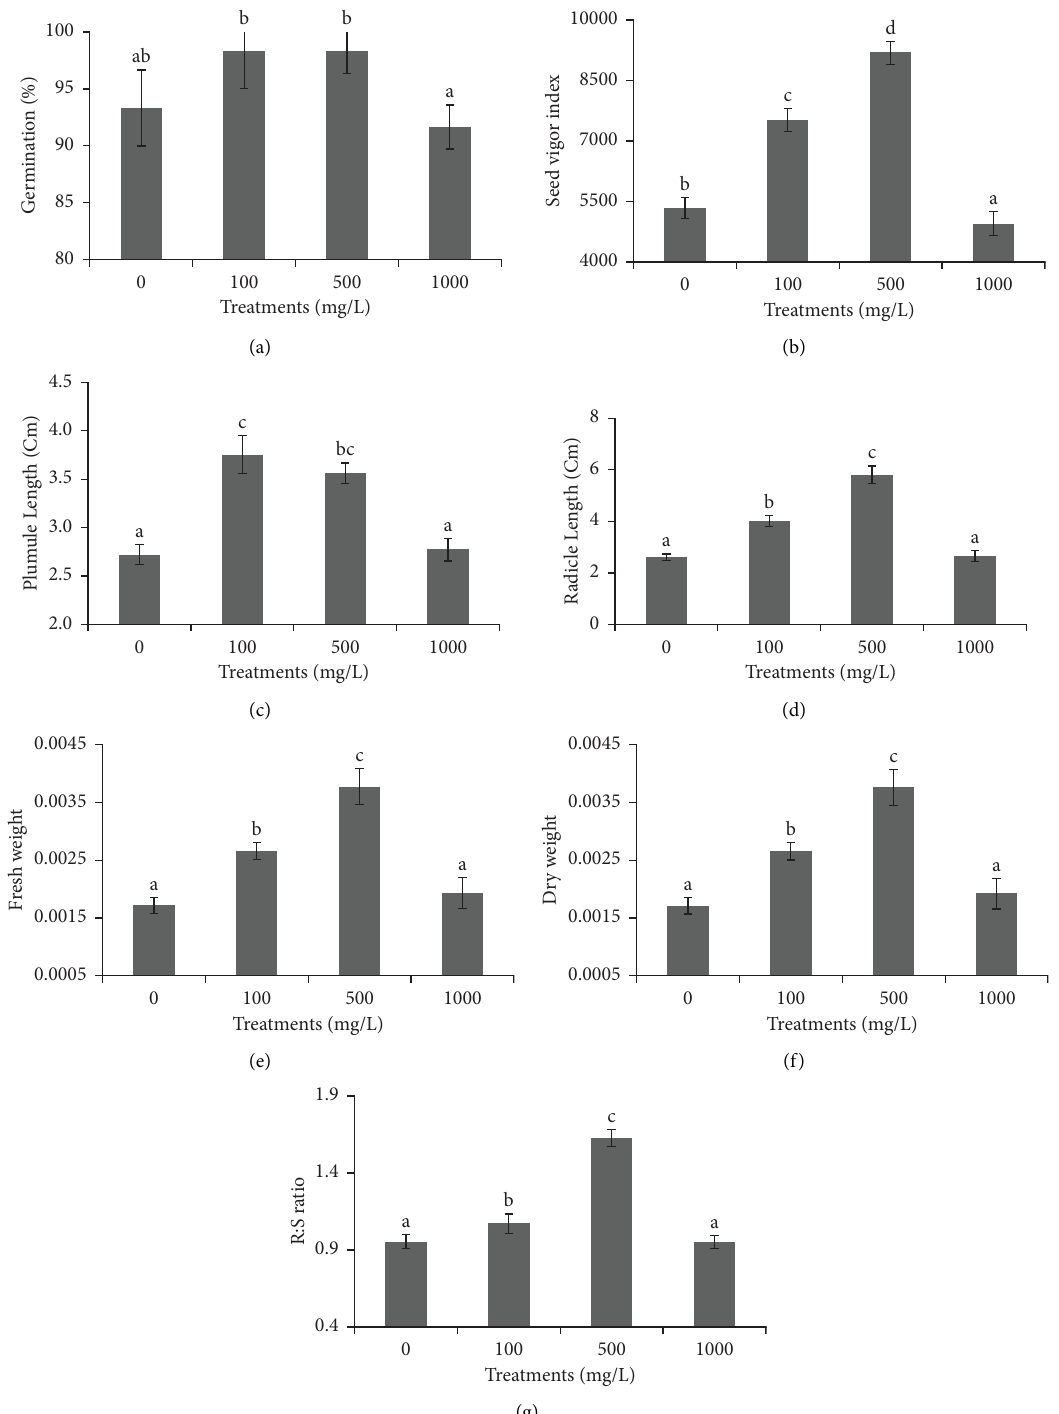
Figure 6: Efect of ZnO NPs at diferent concentrations (0, 100, 500, and 1000mg/L) on seed germination (a), seedling vigor (b), plumule length (c), radicle length (d), fresh weight (e), dry weight (f), and R :S ratio (g) of Eleusine coracana (L.) Gaertn under in vitro conditions. Results are indicated as means of three replications, and vertical bars express the standard deviation (SD) of the means. Diferent letters denote signifcant diferences among treatment outcomes taken at the same time interval according to Duncan’s multiple range test at P ≤